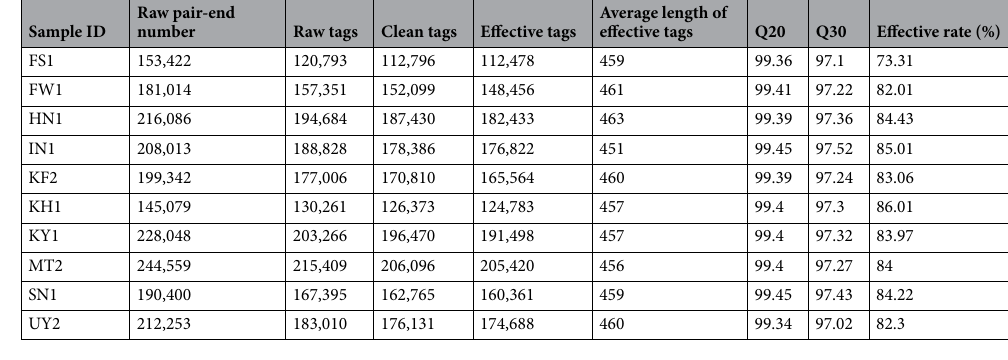
Table 3. The statistics of ultra-deep amplicon sequencing for microbiome profiling. Raw pair-end number are the number of total pair-end reads derived from the samples. Raw Tags are the tags merging the pair-end reads. Clean Tags are the remaining tags after low-quality and unusually short tags are removed. Effective Tags are the remaining tags after the chimera are removed. Q20 and Q30 refer to the percentage of bases with individual Q values greater than 20 (representing the sequencing error rate less than 1%) and 30 (error rate less than 0.1%) in effective tags. Effective rate (%) is the ratio of the number of effective tags and the number of Raw pair-end